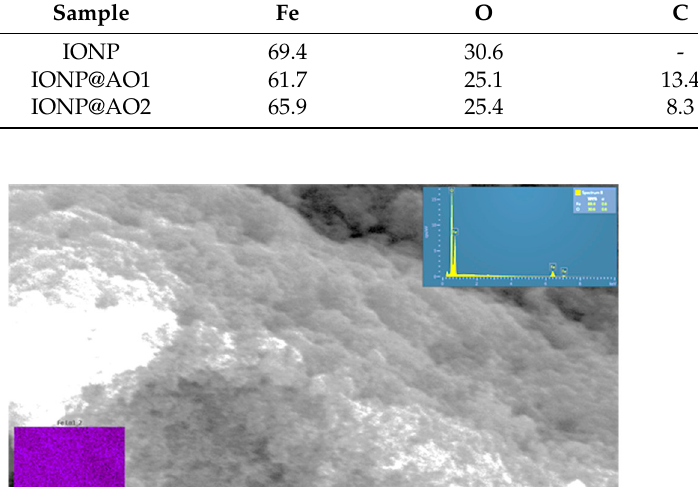
Table 2. Elemental composition analysis employing SEM–EDX energy-dispersive X-ray spectrum. Sample